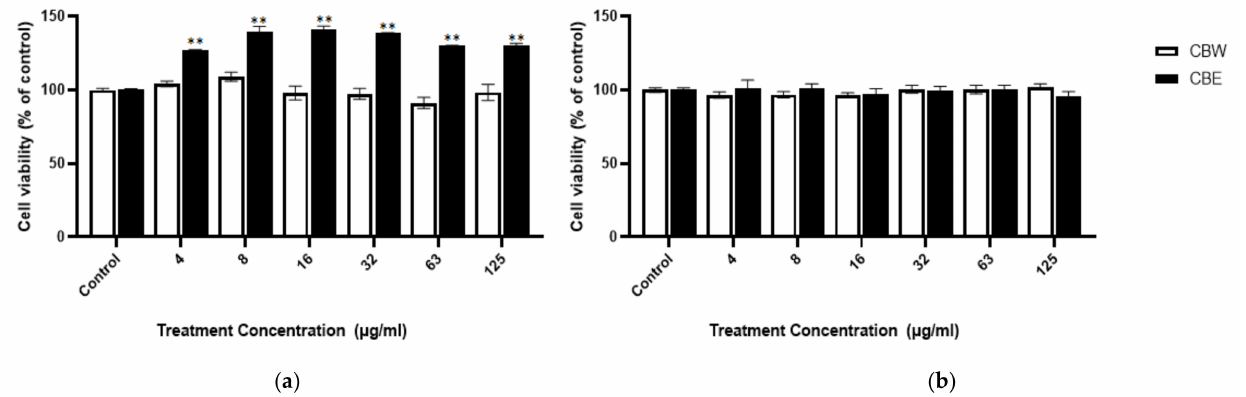
Figure 2. Cell viability assay: relative cell viability of ( a ) MC3T3-E1 and ( b ) MG63 after incubation with CBW and CBE for 24 h. T-test was performed for the control and treatment groups. Data show the mean ± SD ( n = 3). ** p < 0.0001 compared with the control group.